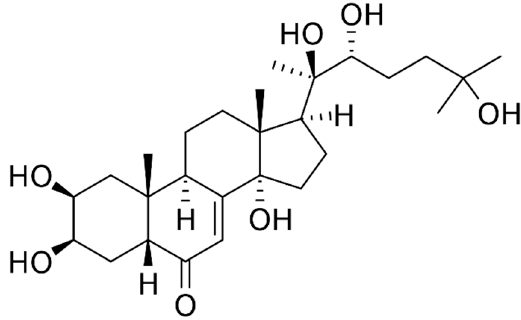
Figure 3. Chemical structure of 20-Hydroxyecdysone.